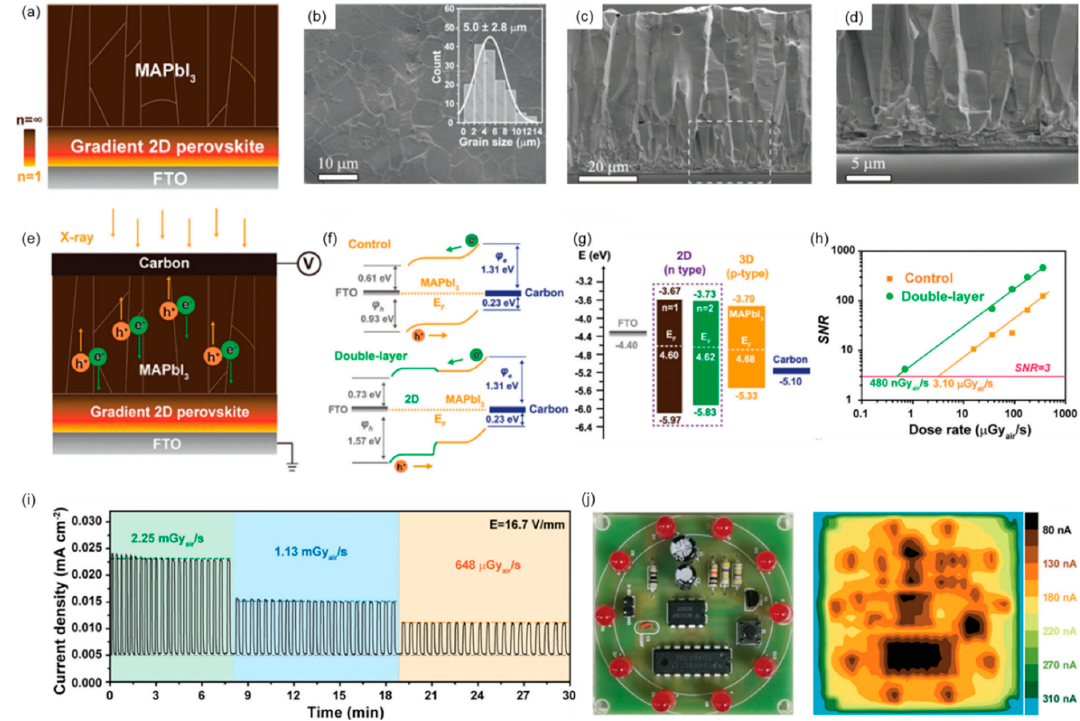
Figure 8. Three-dimensional/low-dimensional hybrid perovskites-based X-ray detectors. Reprinted with permission from Ref. [57]. 2021, Wiley. ( a ) Schematic diagram illustrating the structure of a double-layer perovskite thin film, where gradient 2D perovskite was prepared from a precursor solution with the nominal component (PEA) 2 MA 3 Pb 4 I 13 . ( b – d ) SEM image of double-layer perov- skite film, shown in ( b ) is the grain size distribution. ( e ) Double-layer perovskite X-ray detector equipment configuration: Carbon electrodes were exposed to incident X-ray photons and negatively biased, whereas gradient 2D perovskite was prepared from a precursor solution with the designated component (PEA) 2 MA 3 Pb 4 I 13 . ( f ) Control the interfacial level alignment of a device made of a double-layer perovskite film. ( g ) Band edge position diagram of two-dimensional perovskite and three-dimensional MAPbI 3 with respect to fluorine-doped SnO 2 (FTO) and carbon. ( h ) The dose- rate-dependent signal-to-noise ratio of control and double-layer perovskite detectors. ( i ) Stability test of double-layer perovskite detector under different dose rate X-ray irradiation. ( j ) A digital photograph of the printed circuit board (size: 5.1 cm × 5.1 cm) and X-ray images of a printed circuit board obtained with a double-layer perovskite detector with an active area of 3 mm × 3 mm.